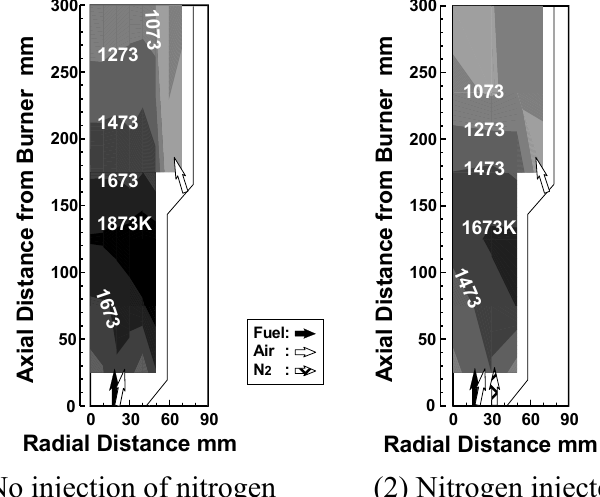
Figure 68. Effect of nitrogen injection on combustion gas temperature distributions using model combustor.